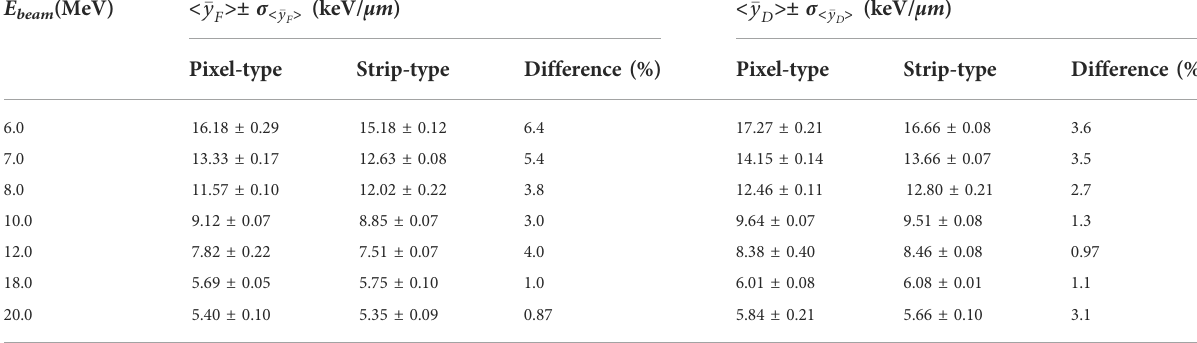
TABLE 2 Values of < (cid:1) y F > , σ < (cid:1) y E (MeV) beam